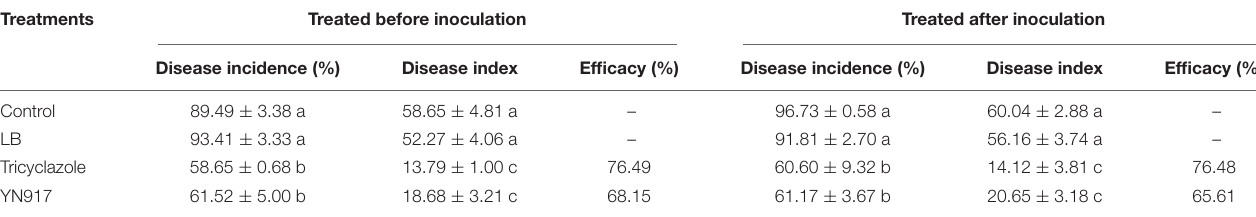
TABLE 4 | Disease index development 7 days after inoculation with strain Bacillus cereus YN917 following protective and therapeutic spray treatments. Treatments Treated before inoculation Treated after inoculation Disease incidence (%) Disease index Efficacy (%) Disease incidence